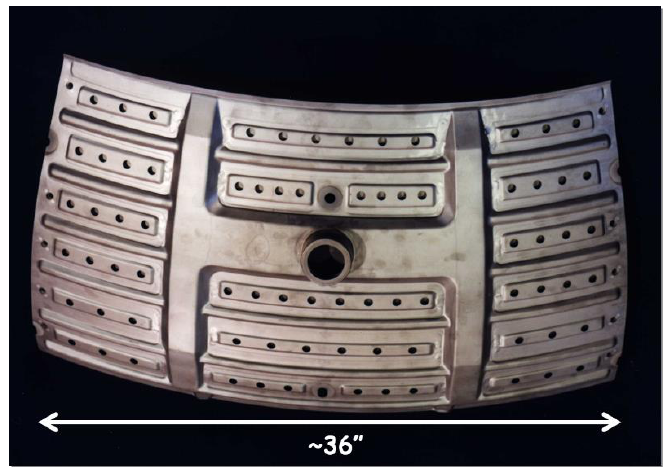
Figure 3. Example of a complex sheet metal engine part made by superplastic forming and diffusion bonding (SPFDB) [2].